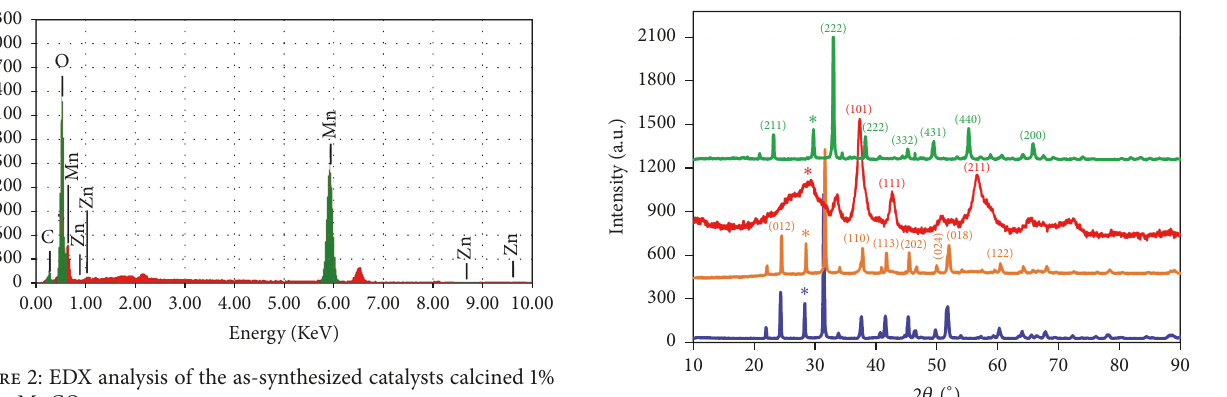
–MnCO 3 uncalcined x –MnCO 3 ; x –Mn 2 O 3 x